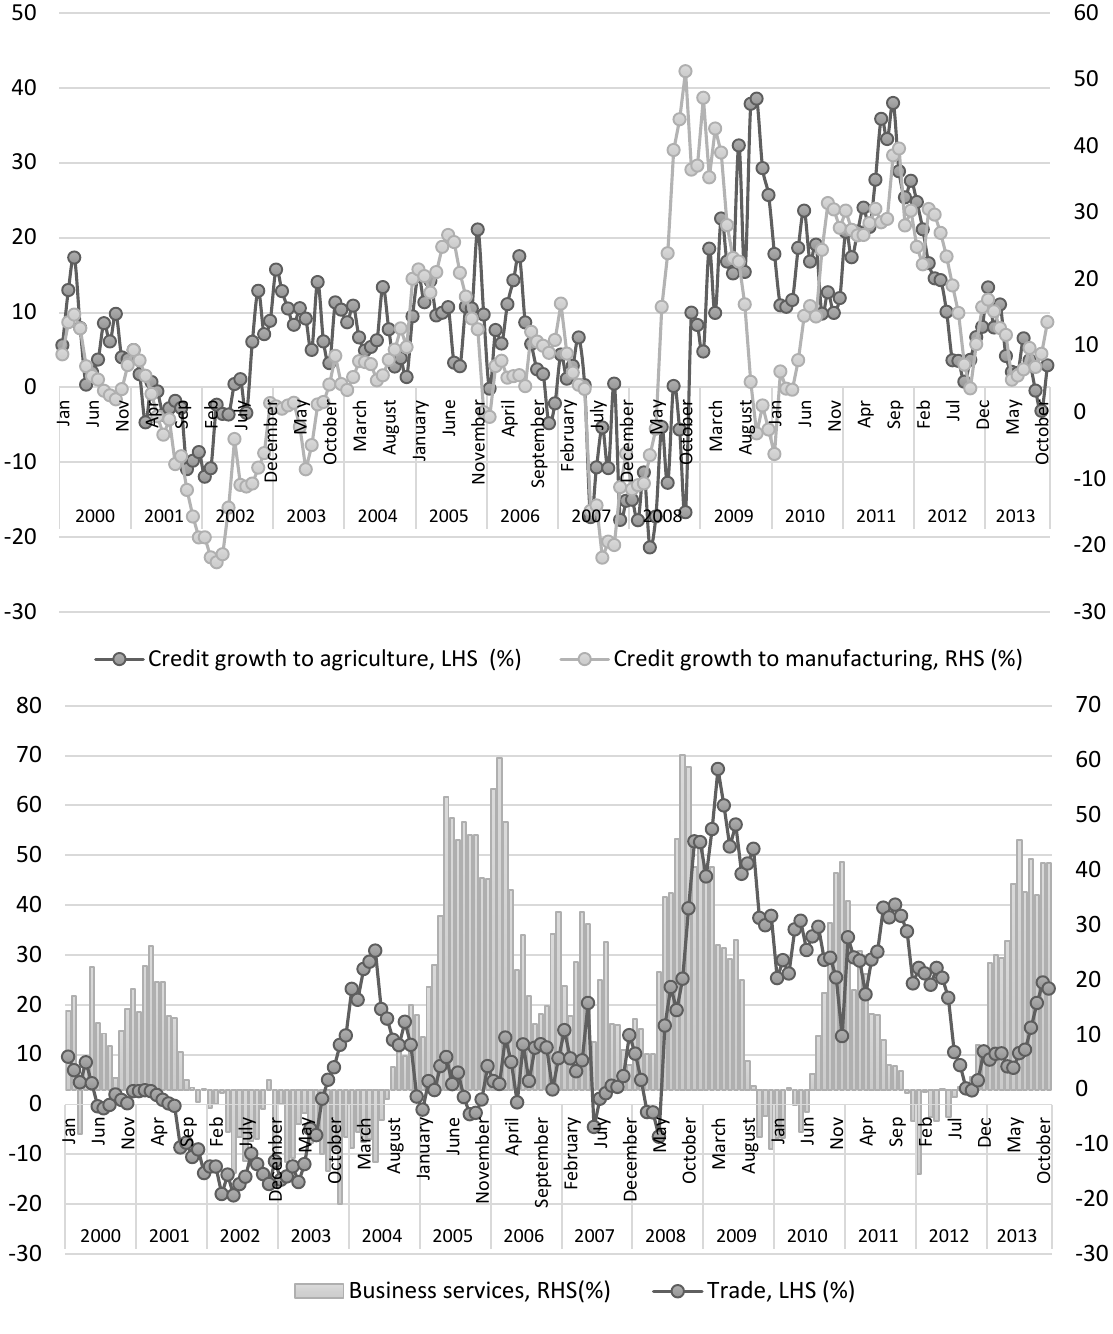
Figure 3а. Private sector credit by sector in the